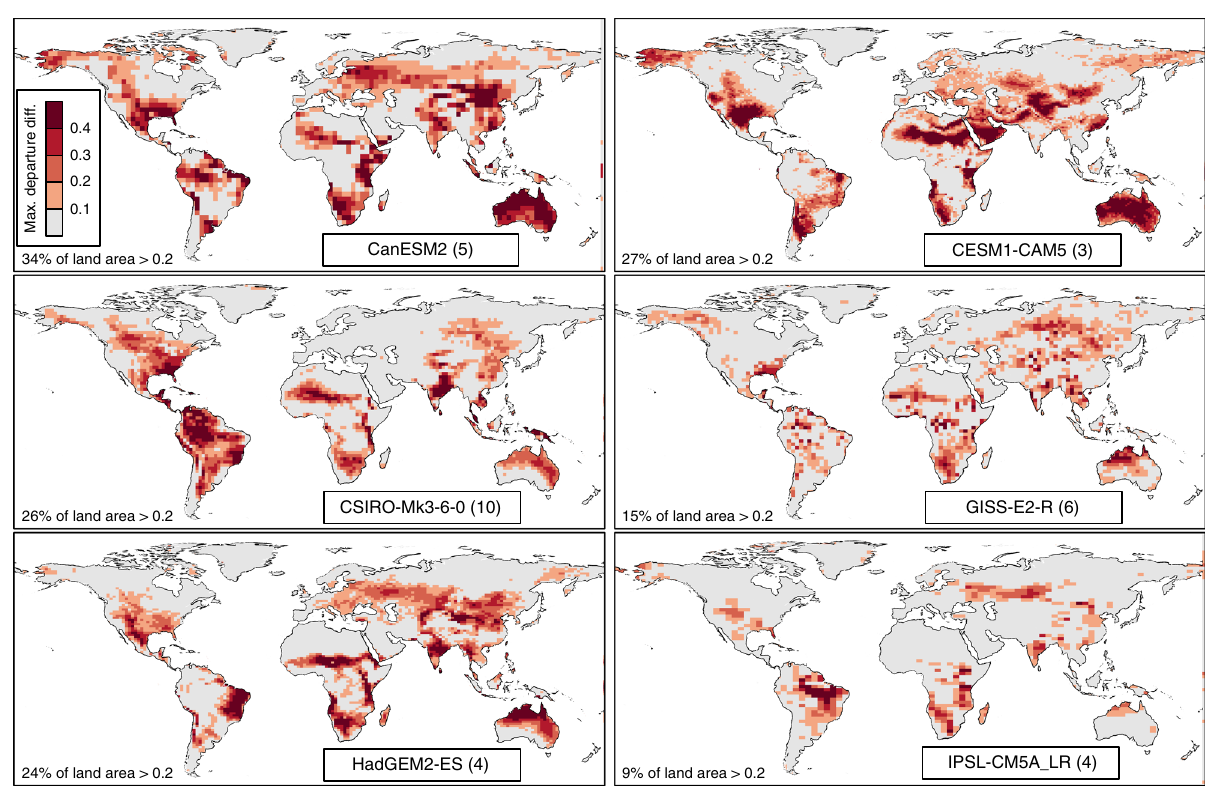
Fig. 3 Intermodel variation in departure intensi fi cation in summertime temperature and precipitation. Departure intensi fi cation, measured as maximum departure difference, is calculated from the mean time series of univariate and bivariate 2 σ proportions of historical + RCP4.5 runs for each CMIP5 model. The number of runs in each ensemble is indicated in parentheses next to the model name. Departure difference is the frequency of bivariate 2 σ proportions minus the frequency of univariate (greater of temperature or precipitation) 2 σ proportions, both with respect to the 1850 – 2005 historicalNat simulations in each model. Positive values indicate a greater frequency of departures in the bivariate temperature-precipitation regime than in temperature or precipitation alone. Summer months are JJA (Northern Hemisphere) and DJF (Southern